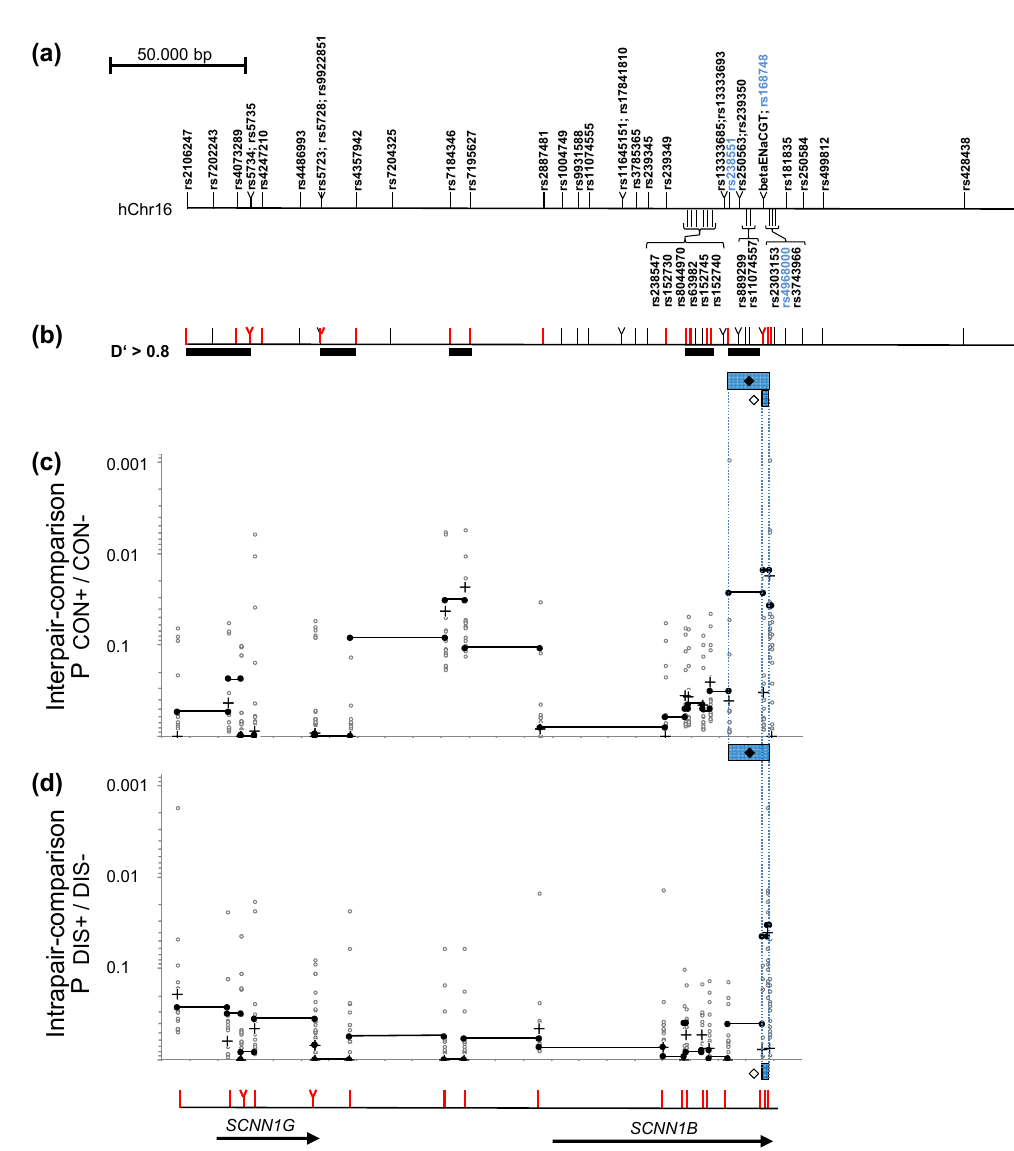
Figure 1. Mapping of a regulatory element within SCNN1B using an association study in two non-overlapping sets of affected patent pairs ( a ) Genomic map of the SCNN1B/SCNN1C region analysed by 7 previously typed markers (Stanke et al., 2006) and 49 SNPs genotyped for fine-mapping. Markers rs238551, rs168748 and rs4968000 are highlighted in blue as they define the fragments of interest (see ( c ), ( d )). ( b ): Markers depicted in red are informative (MAF > 0.4) and were used to describe haplotype blocks (D’ > 0.8; black bars) and map association signals for interpair-comparison of concordant mildly (CON+) and concordant severely (CON − ) affected patient pairs ( c ) and for intrapair comparison of mildly (DIS+) and severely (DIS − ) affected siblings within discordant pairs ( d ). ( c , d ): Association signals comparing CF patients with contrasting phenotypes. p -values corrected for multiple testing of 20 informative markers were: Pcorr CON+/CON − = 0.0528 and Pcorr DIS+/DIS − = 0.05. Uncorrected raw P values are shown for single markers (+), 2-marker-haplotypes of adjacent informative markers (filled circles in all diagrams; genomic segments spanned by two adjacent markers are linked by a black line) and 2-marker-haplotypes of non-adjacent markers (open circles). ( c ): Interpair comparison of concordant sibling pairs: P values were computed comparing haplotype distributions of 11 concordant mildly affected patient pairs (CON+) and 10 concordant severely affected patient pairs (CON − ). The fragment marked (cid:7) corresponds to rs238551 to rs4968000. ( d ): Intrapair comparison within discordant pairs. P values were computed comparing the mildly affected sibling (DIS+) to the severely affected sibling (DIS − ) for 14 discordant pairs. The fragment marked ♦ corresponds to rs168748 to